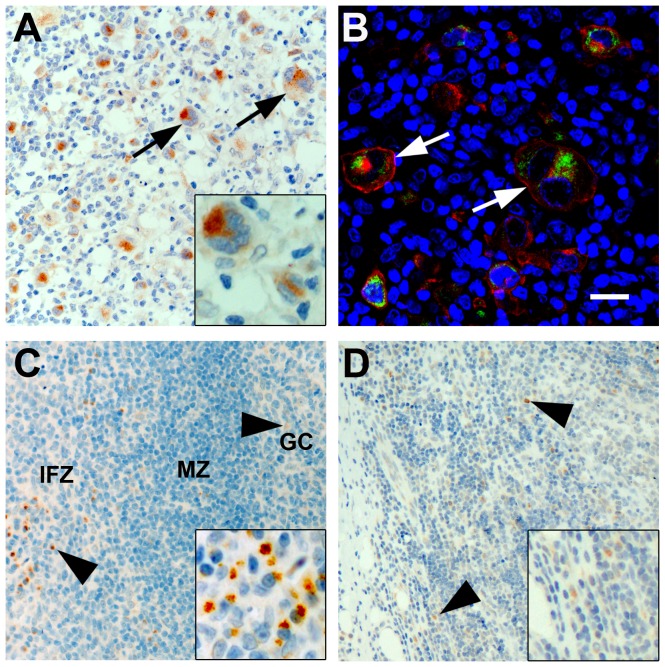
Expression of CB1-receptor in classical Hodgkin lymphoma and reactive non-neoplastic lymphatic tissues.A) Immunohistochemical staining of CB1–N in classical Hodgkin lymphoma showing strong expression of CB1 in HRS cells (arrows). B) Confocal image showing CB1 (green), CD30 (red) and DAPI-stained nuclei (blue) in cHL. Note the CB1 negativity in non-neoplastic infiltrate. C) In a case of reactive tonsillitis, CB1-positive cells (arrow heads) were found in the inter-follicular zone (IFZ) and to a lesser extent in germinal center (GC) and mantle zone (MZ). D) Few disseminated cells were found CB1-positive (arrow heads) in a case of lymphadenitis. Bars  =  20 µm.